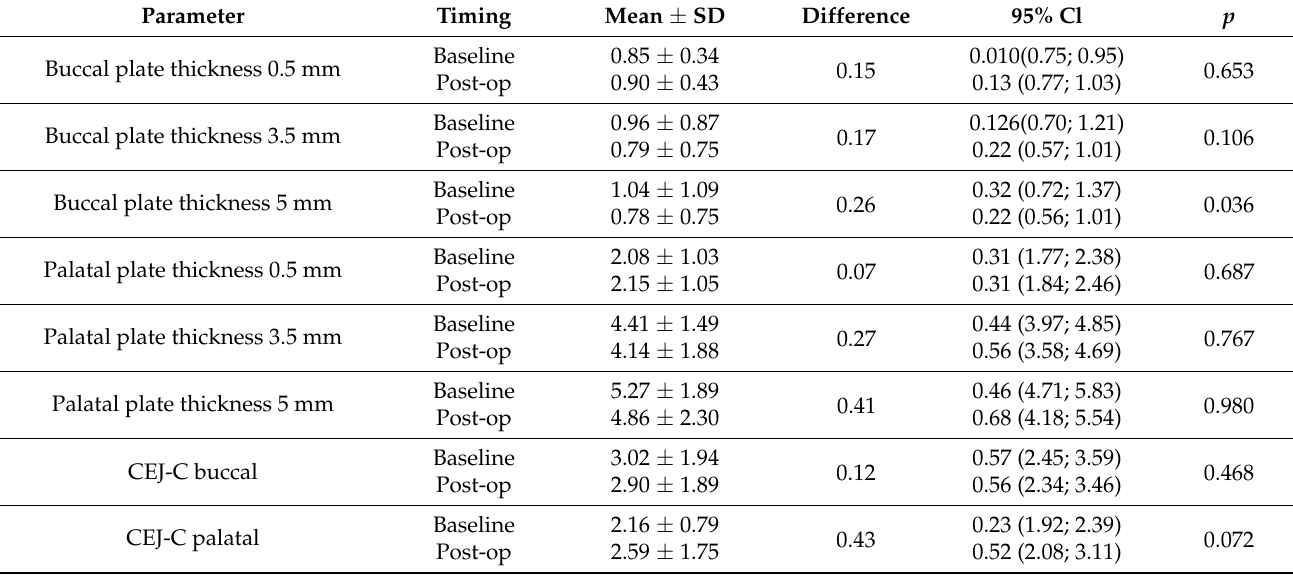
Table 7. Distribution of CBCT parameters for mesial molars’ roots before and after orthodontic treatment.